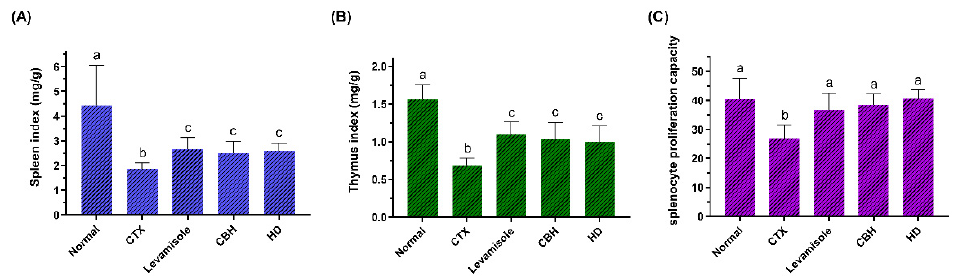
Figure 2. The effect of CHB and HD on the spleen index ( A ), thymus index ( B ), and the proliferation of splenocytes stimulated with Con A (7.5 µ g/mL) ( C ). Data are presented as means ± SD ( n = 10). Different letters for the same index among the groups represent significant differences at p < 0.05.